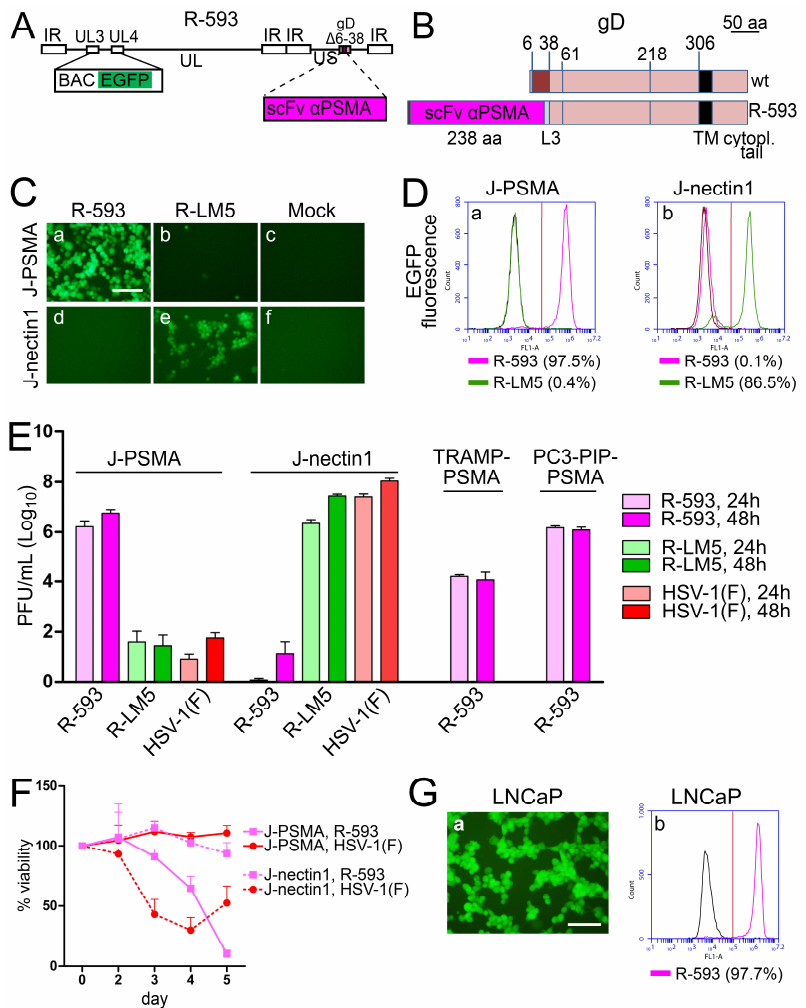
Figure 2. Properties of PSMA-retargeted R-593. ( A ) Schematic drawing of the R-593 genome. Inverted repeat (IR) sequences are represented as rectangular boxes. The scFv to PSMA is inserted in gD, in place of aa 6–38. pBeloBAC11 and EGFP (BAC EGFP) are inserted between UL3 and UL4 [50]. ( B ) Schematic linear maps of R-593 gD, and of wt gD. The aa coordinates relevant to this study are indicated. The two linear maps are drawn to scale. Scale bar, 50 amino acid residues. Note that the size of R-593 gD is almost doubled relative to that of wt gD, as a consequence of scFv insertion. L3, linker 3. ( C ) J-PSMA or J-nectin1 cell lines were infected with the indicated viruses at 10 PFU/cell. Pictures were taken at 24 h p.i. The levels, brightness, and contrast of the panels were adjusted by means of Adobe Photoshop as follows: input level (black) 30, brightness +60, contrast +60, scale bar =100 µ m. ( D ) J-PSMA or J-nectin1 cells exposed to 10 PFU/cell of R-593 or R-LM5 or mock infected (black line); at 24 h after infection, the infected cells were analyzed for EGFP fluorescence by flow cytometry. The figures next to each virus name indicate the percentage of infected cells. Vertical red line: threshold discriminating the negative and positive populations, as determined by comparison with the negative control. ( E ) R-593 replication in J-PSMA, J-nectin1, or the PSMA-expressing prostate murine (TRAMP-PSMA) or human (PC3-PIP-PSMA) tumor cell lines. Cells were infected at 0.1 PFU/cell, and harvested at 24 or 48 h after infection. The plotted values represent the average of three independent experiments (for J-PSMA and J-nectin1) or two independent experiments for TRAMP-PSMA and PC3-PIP-PSMA, ± SD. ( F ) Effect of virus infection on viability of J-PSMA (solid lines) or J-nectin1 (dashed lines) cells, infected at 2.5 PFU/cell. The data represent the average of four replicate samples ± SD. ( G ) R-593 infection of the human prostate cancer cell line LNCaP detected by fluorescence microscopy (panel a). Panel b shows the extent of infection as detected by flow cytometry. Vertical red line: threshold between negative and positive populations, scale bar = 100 µ